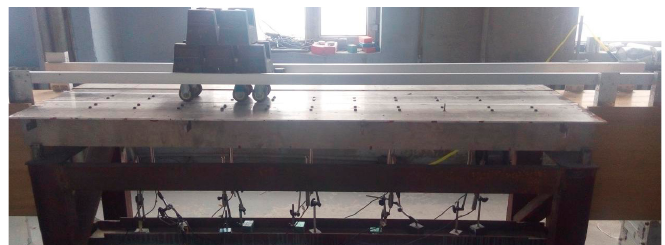
Figure 10. Photo of the entire experimental system of the model bridge.